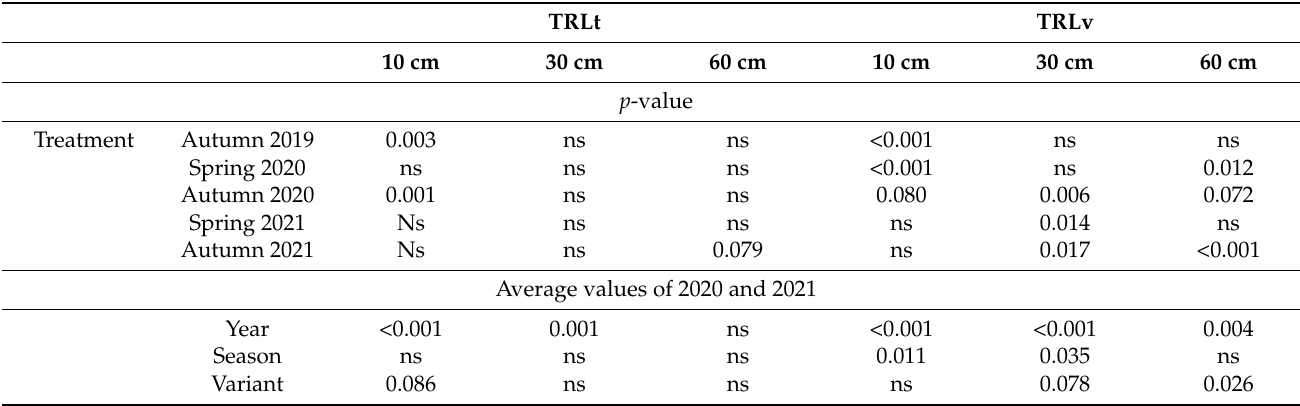
Table 2. The statistical analysis (ANOVA) of the effect of irrigation treatments on the total length of all roots in a sample (TRLt); and the total length of new vital roots in a sample (TRLv) at distances of 10 cm, 30 cm, and 60 cm from the tree trunk.